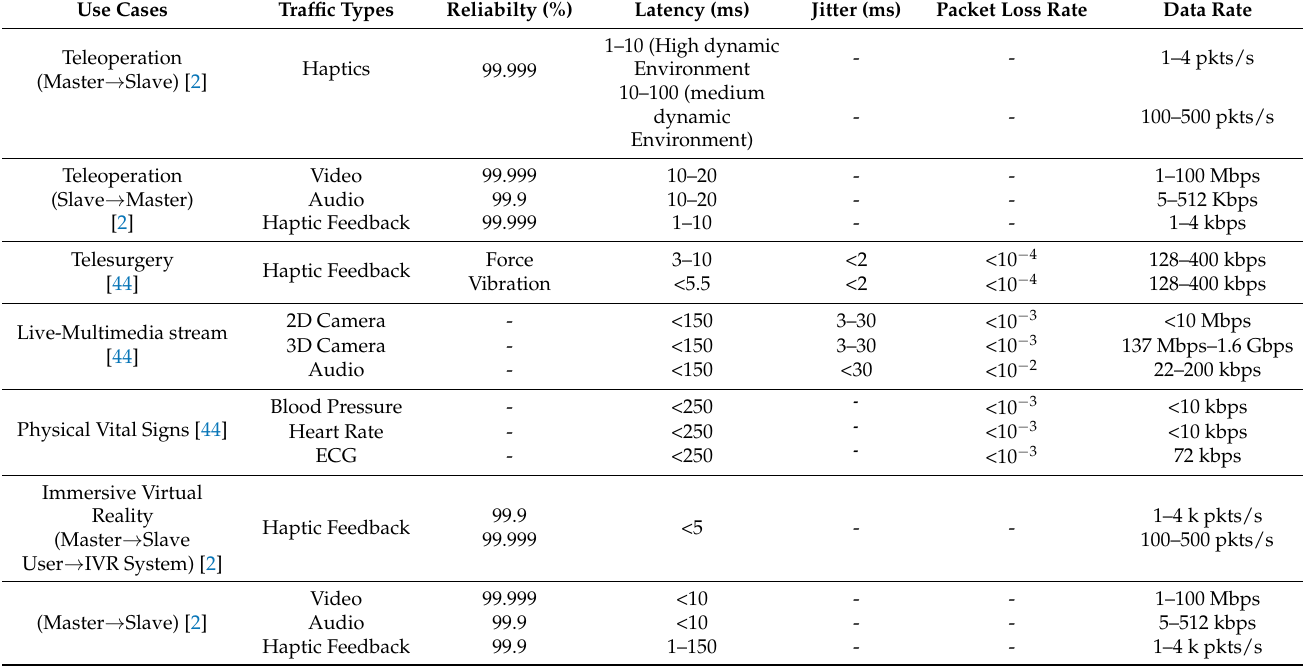
Table 2. Communication QoS requirements for TI Use cases